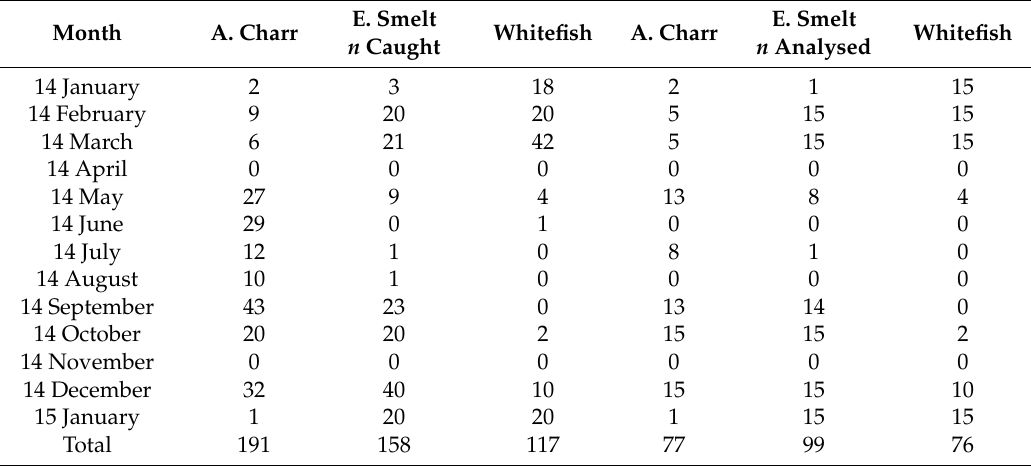
Table 1. Catch of each species each month, and analysed fish per